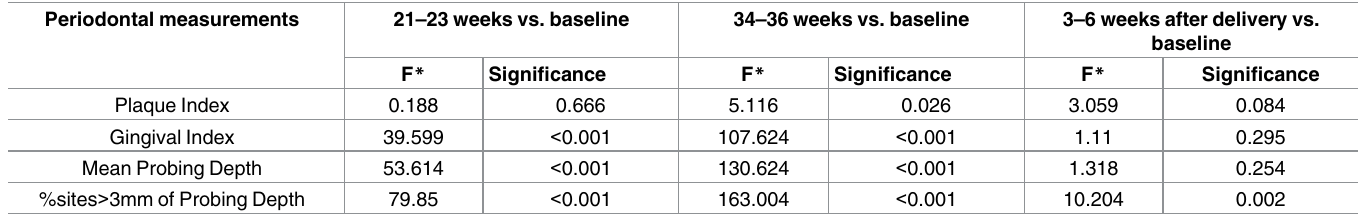
Table 1. Multiple comparisons among the different periodontal